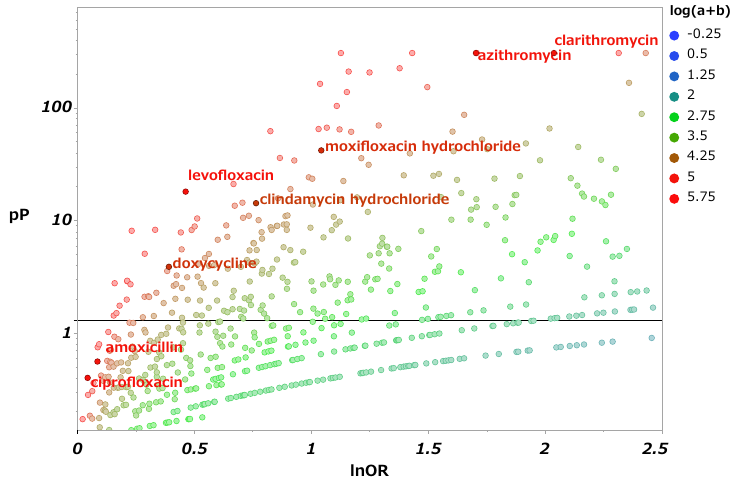
Figure 1. Taste and smell disorders associated with pharmaceuticals. This figure presents the relationships between taste and smell disorders and suspected causative drugs. The X-axis is the logarithm of the reporting odds ratio (lnOR), and the Y-axis is the negative logarithm of the P value calculated using Fisher’s exact test (− log P value; pP). The horizontal line in the figure indicates the reference line at pP = 1.3 ( P = 0.05). a +